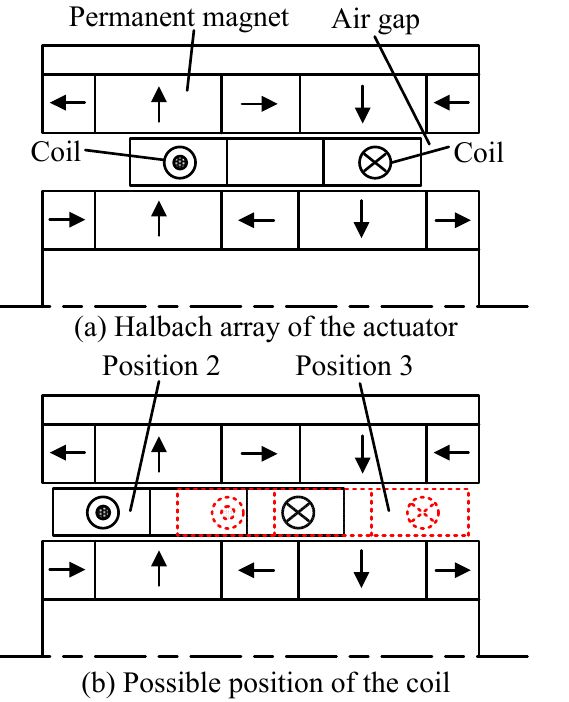
Figure 5. The Halbach structure of the ELA: ( a )Halbach array of the actuator; and ( b ) Possible position of the coil.